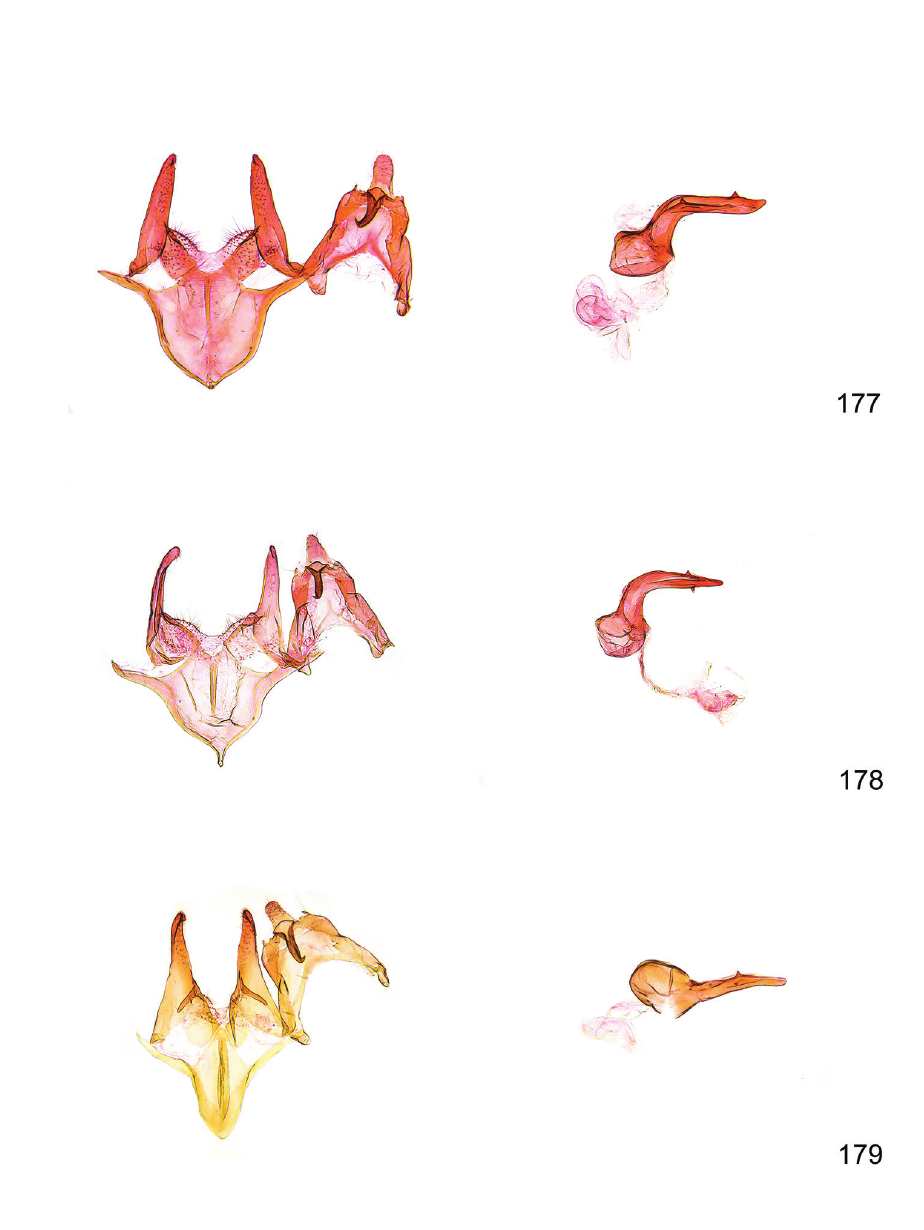
Figures 177–179. Megacraspedus male genitalia. 177 M. cuencellus Caradja, 1920 – Spain, GU 15/1401 P.H. (ZMUC) 178 M. bidentatus sp. n. – Holotype, Spain, GU 16/1433 P.H. (ZMUC) 179 M. fuscus sp. n. – Holotype, Spain, GU 17/1478 P.H.